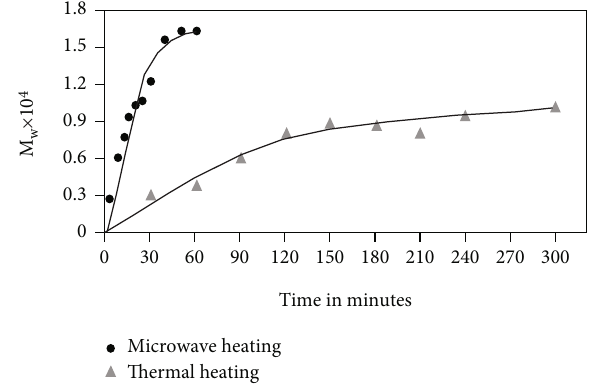
Figure 8: Poly(butylene succinate) molecular weight evolution during its synthesis (reprinted from Velmathi et al. [49] with permission. Copyright © 2005, WILEY-VCH Verlag GmbH & Co. KGaA,